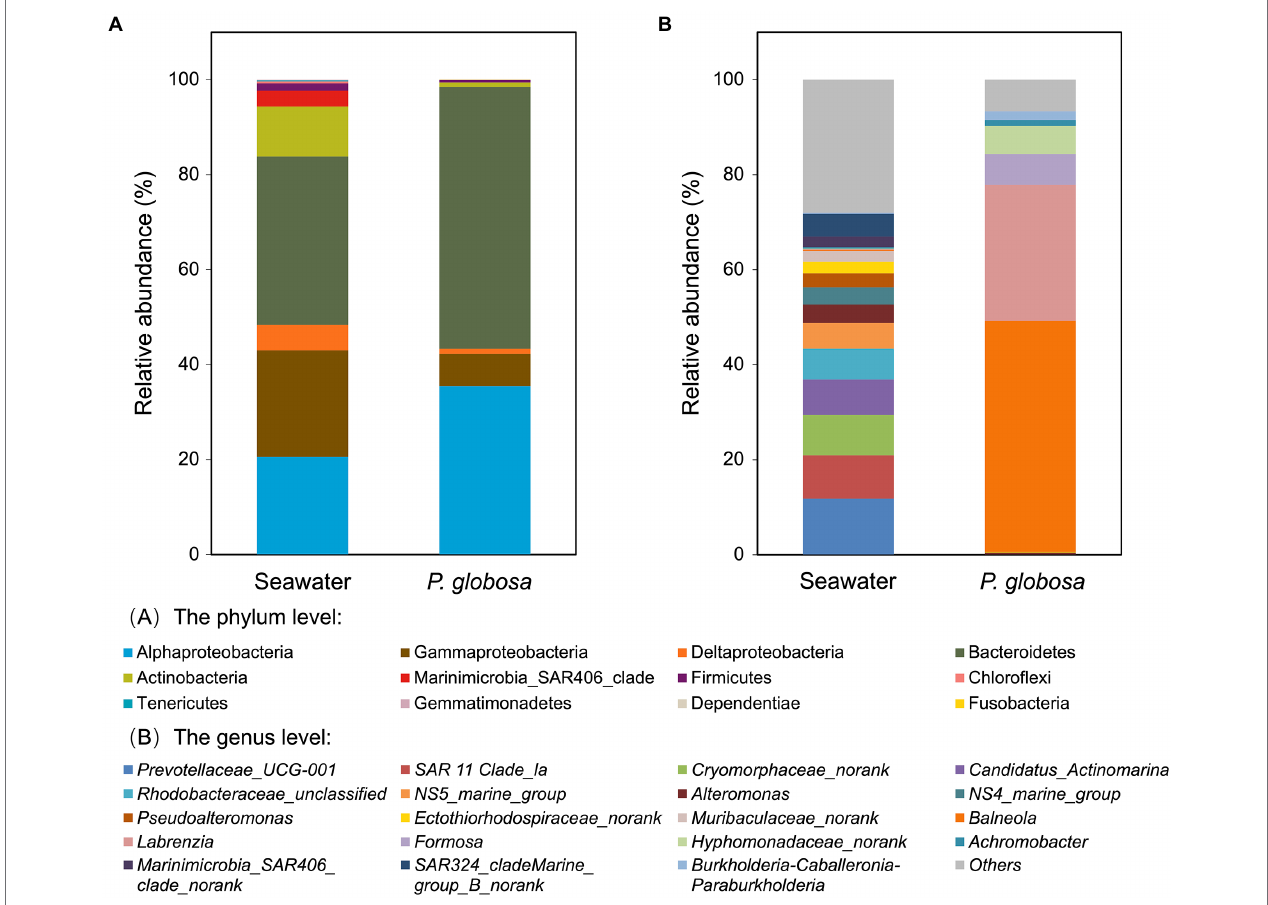
FIGURE 3 | Bacterial composition of ambient seawater and P. globosa intracolonial fluid. The stacked bar plots show the relative abundance of operational taxonomic units (OTUs) at phylum levels (A) and genus levels (B) . Proteobacteria OTUs has been displayed at the subclass levels (alpha, beta, gamma and delta) (A) . Each bar represents the average of pooled